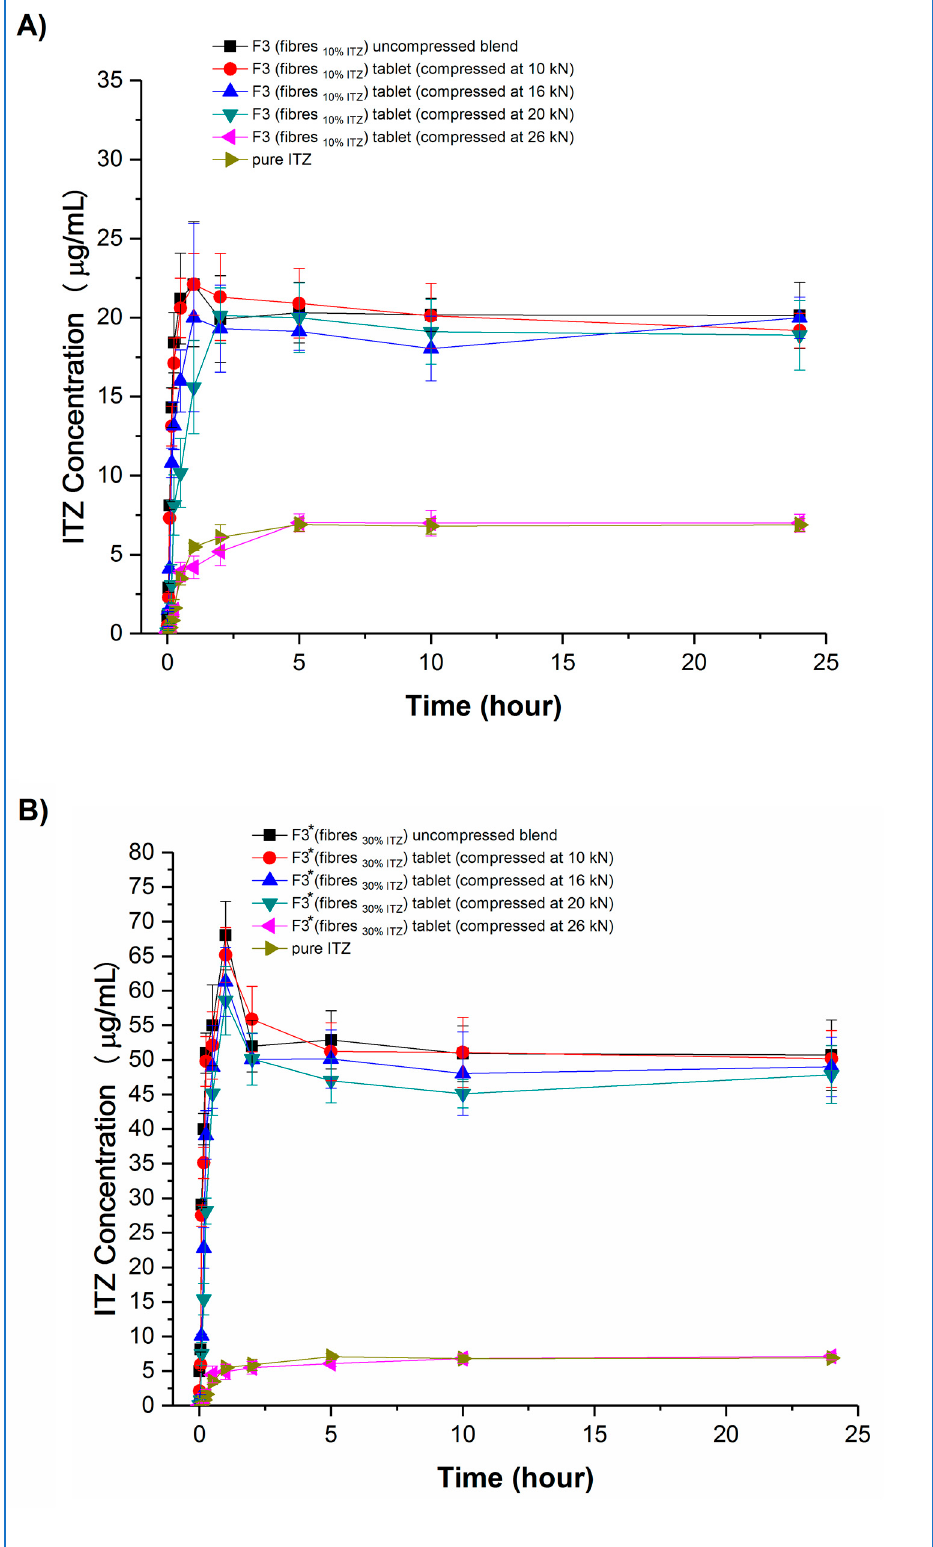
Figure 10. Dissolution–supersaturation profiles obtained under non-sink conditions for tablets, the corresponding uncompressed blends, and pure crystalline itraconazole. ( A ) F3 tablets, and ( B ) F3* tablets. (ITZ = itraconazole).